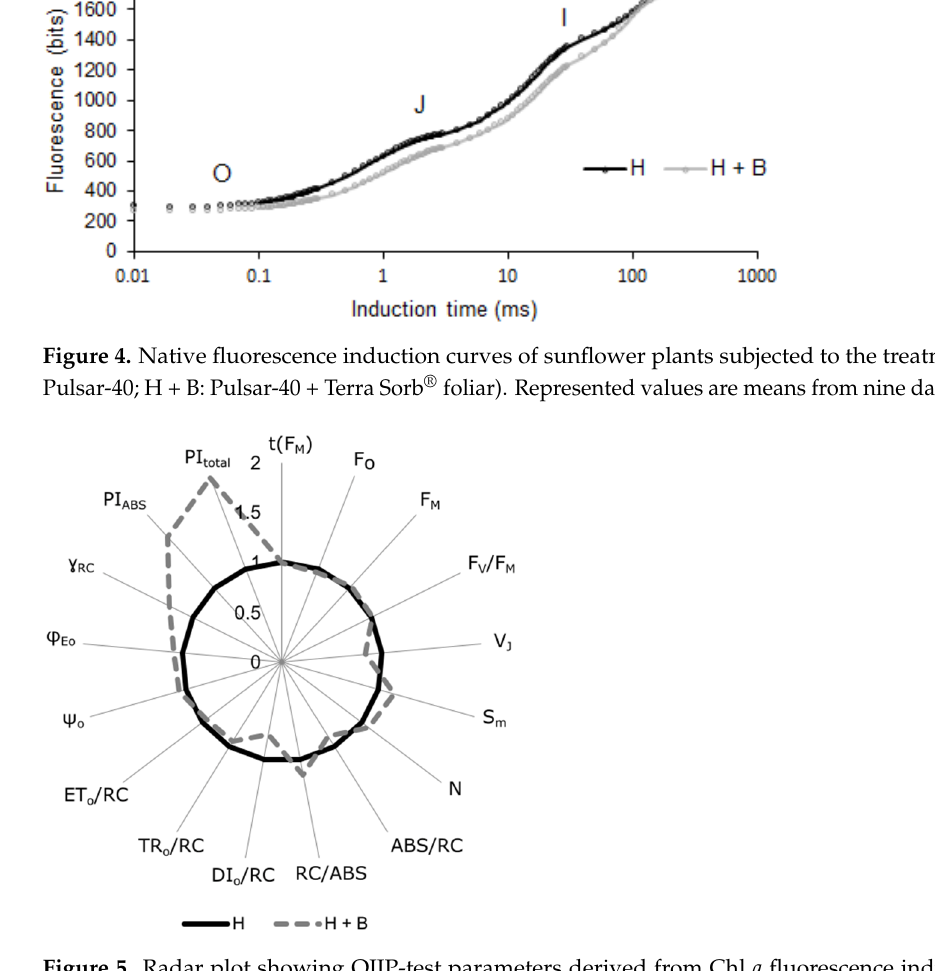
Figure 5. Radar plot showing OJIP-test parameters derived from Chl a fluorescence induction in sunflower plants subjected to H + B treatment: Pulsar-40 + Terra Sorb ® foliar. Data normalization were made to enable the representation of all parameters on the same scale. The dotted gray line values represent the relative increase or decrease in plants of the H + B treatment with respect to plants of the H treatment (black line).